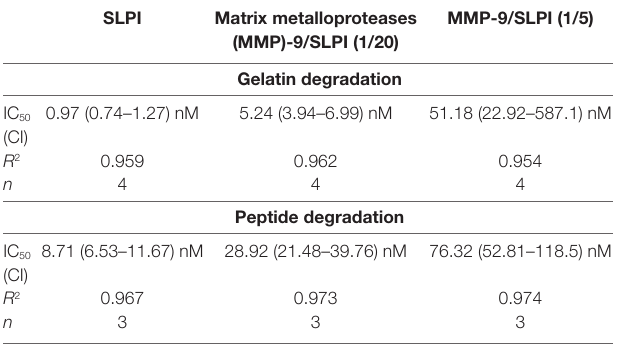
TaBle 1 | Inhibitory capacity of secretory leukocyte peptidase inhibitor (SLPI) and matrix metalloproteinase-9 (MMP-9)-treated SLPI on neutrophil elastase. slPi Matrix metalloproteases MMP-9/slPi (MMP)-9/slPi (1/20)